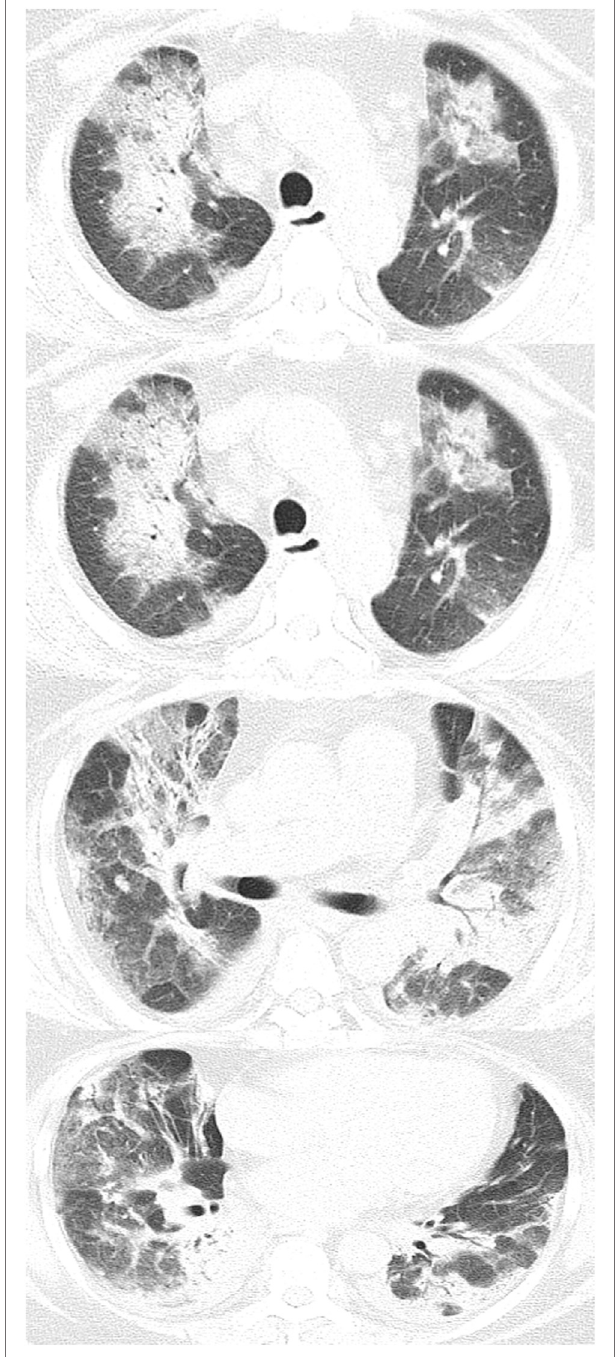
FIGURE 2 | These scans are of a 64 ° year-old woman with an H1N1 infection con fi rmed by a sputum test. Chest CT scan demonstrates patchy shadows and ground-glass opacities in both lungs, with traction bronchiectasis and pleural thickening.